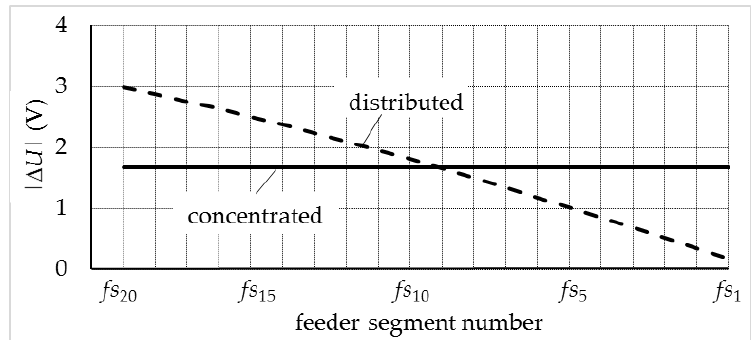
Figure 7. The theoretical voltage drop amplitude in every feeder segment as a function of the bus number for the distributed and concentrated var-sink cases.